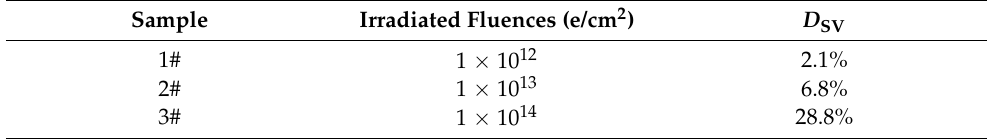
Table 2. Attenuation rate of voltage magnetic sensitivity for SMST after